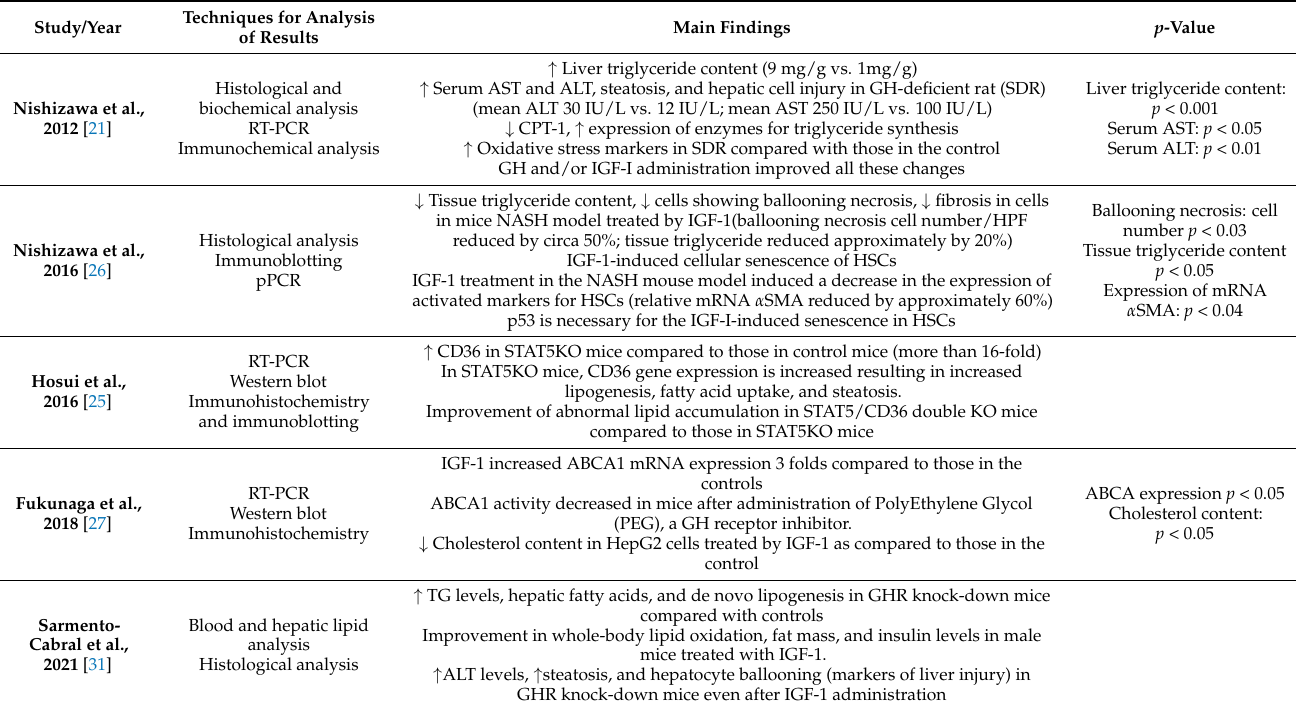
Table 2. Main findings of in vivo and in vitro